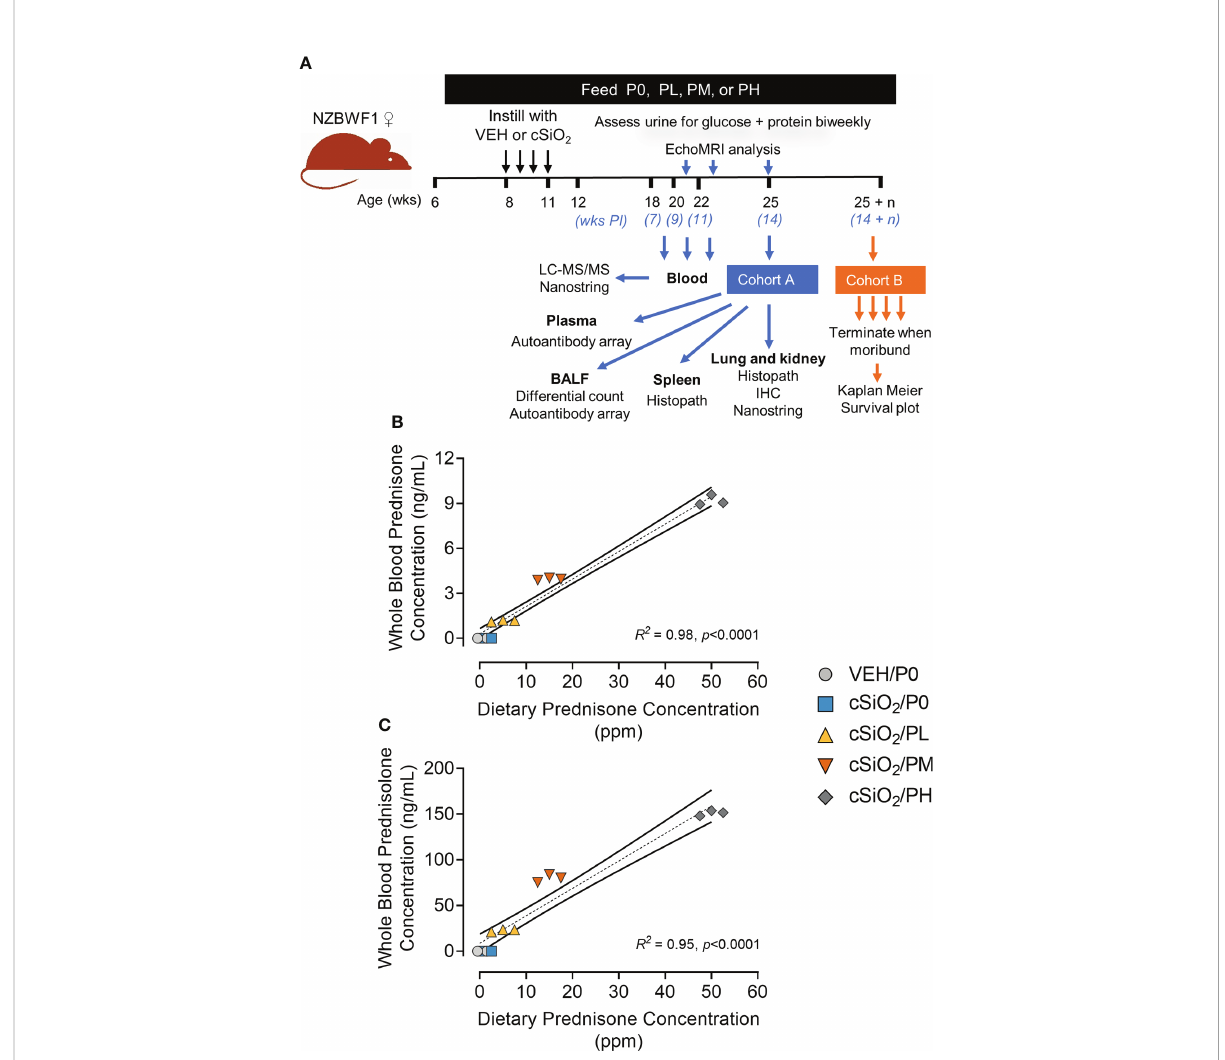
FIGURE 1 Experimental design and con fi rmation of prednisone and prednisolone levels in whole blood. (A) Female NZBWF1 mice obtained at 6 wk of age were immediately placed on either control AIN-93G diet containing no prednisone (P0) or prednisone-amended diets. Diets were maintained throughout the duration of the study. Beginning at 8 wk of age, mice were intranasally instilled with either saline vehicle (VEH) or 1 mg of cSiO 2 once per week for 4 consecutive weeks. Eight animals per treatment group (Cohort A) were sacri fi ced at 25 wk of age to evaluate relevant endpoints for onset of pulmonary and renal autoimmunity. The remaining 9 mice per treatment group (Cohort B) were maintained until they met moribund criteria and were humanely sacri fi ced. Health and proteinuria were monitored following cSiO 2 instillations to evaluate disease progression. Food intake, body weights, and fat/lean muscle mass composition were monitored as well to assess prednisone-induced toxicity. Levels of prednisone (B) and its active metabolite, prednisolone (C) in whole blood samples taken from mice at 19 wk of age were determined by LC-MS/MS. Samples were pooled within each cage (n=3/cage), with 3 cages per treatment group resulting in an n=3/group for analysis. Prednisone concentration detected in whole blood is predictable based on dietary prednisone concentrations. For regression analyses, R 2 and p-values are reported. Shaded bands around regression lines represents 95% con fi dence